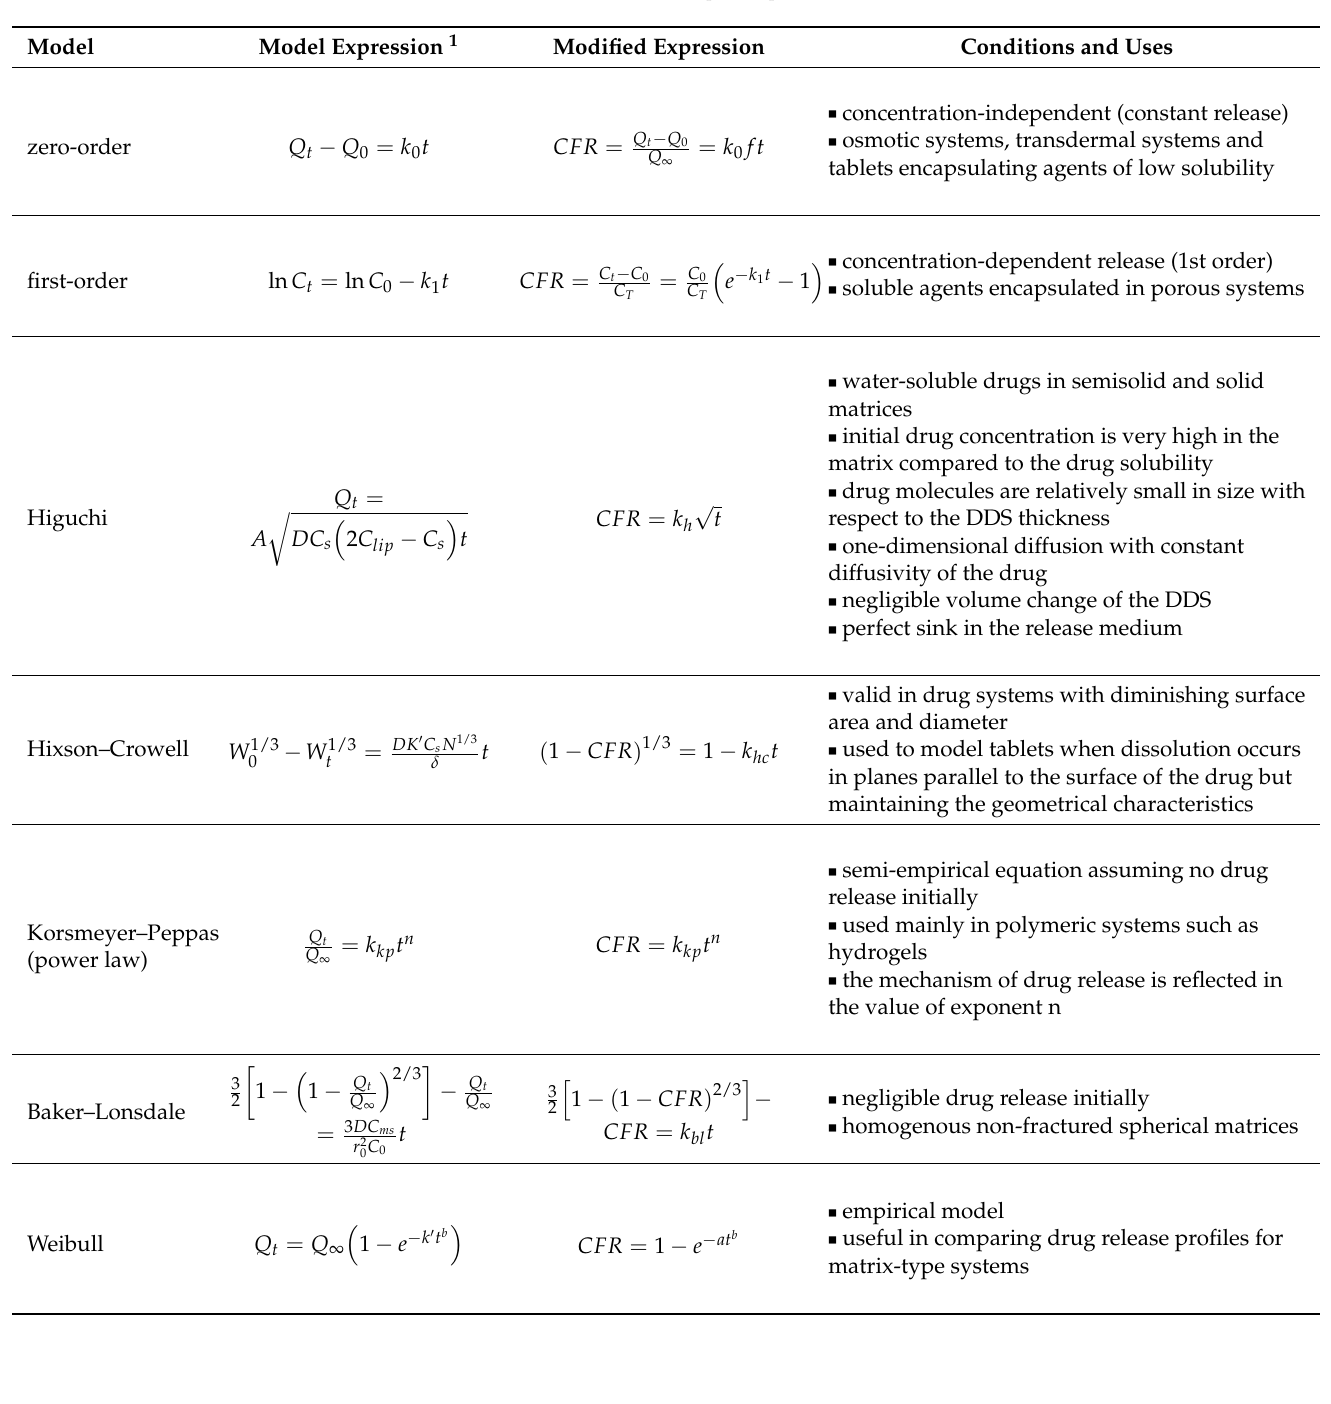
Table 3. Kinetic release models from [35–37]. Table 1. The advantages and disadvantages of drug delivery trigger mechanisms. Table 1. The advantages and disadvantages of drug delivery trigger mechanisms.